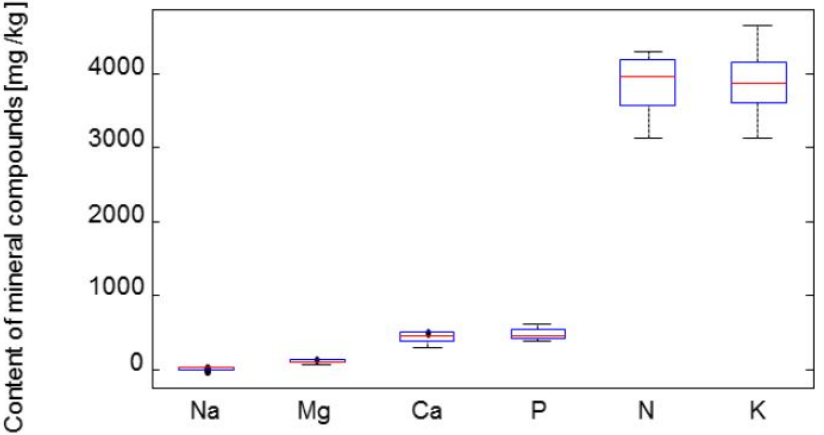
Figure 1. The content of mineral elements expressed by box plot graphs. Na–sodium, Mg–magnesium, Ca–calcium, P–phosphorus, N–nitrogen, K–potassium.